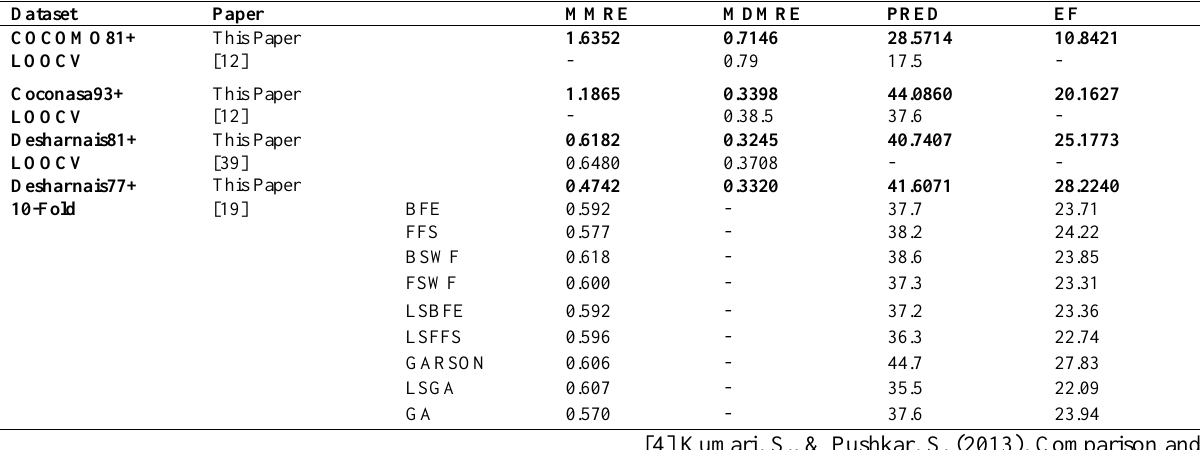
According to different compounds, the common feature of all datasets, “size” feature, is known as the most effective one. Table 7. Comparison between experimental results of this work and other